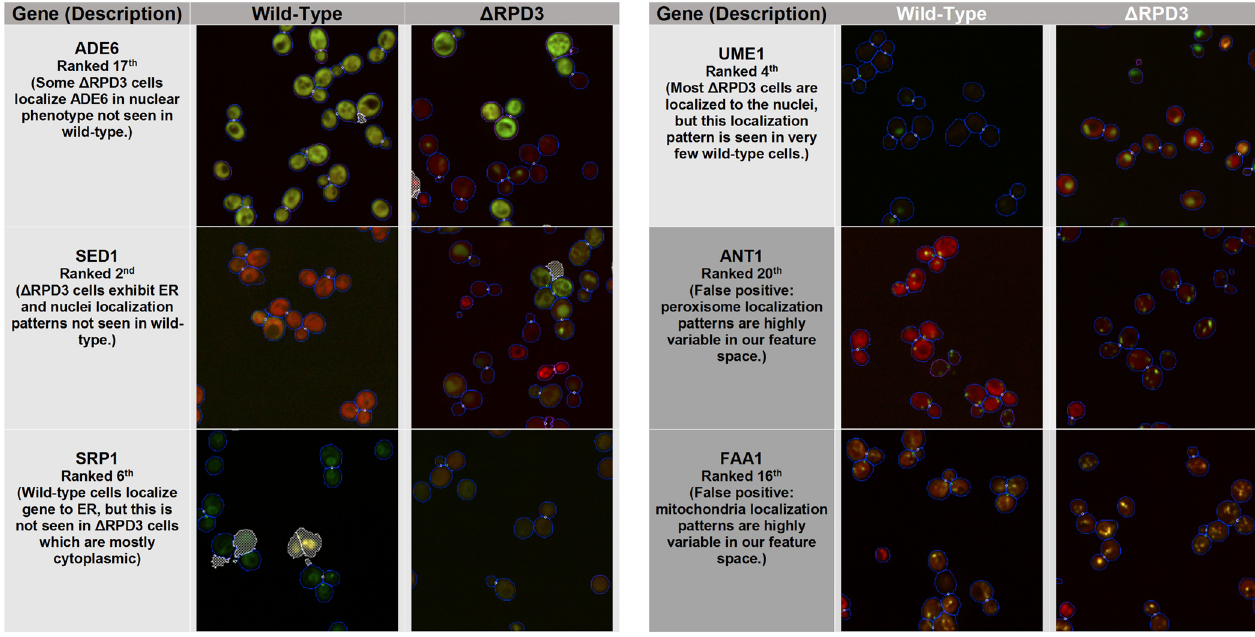
Fig 5. Curated examples from the top 20 ranked genes from the mean profile. Representative images from the wild-type and Δ rpd3 screens are shown for 4 newly-found genes exhibiting localization changes, along with a description the change and the rank of the gene using the mean profile. In addition, we show two examples of false positives in the top 20 ranked genes. Cell segmentations are outlined in blue, with mother-bud associations shown as white circles. The white cross-outed regions are artifacts discarded by the image analysis software.